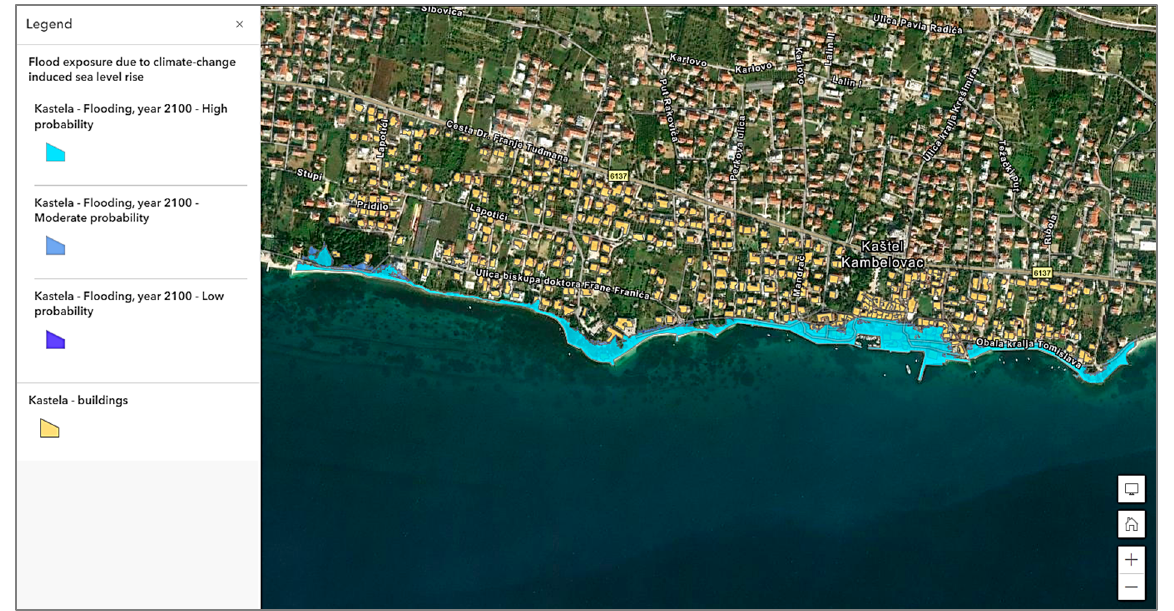
Figure 7. Distribution of critical zones most prone to flood due to impact of climate changes on sea level rise: scenario for year 2100.